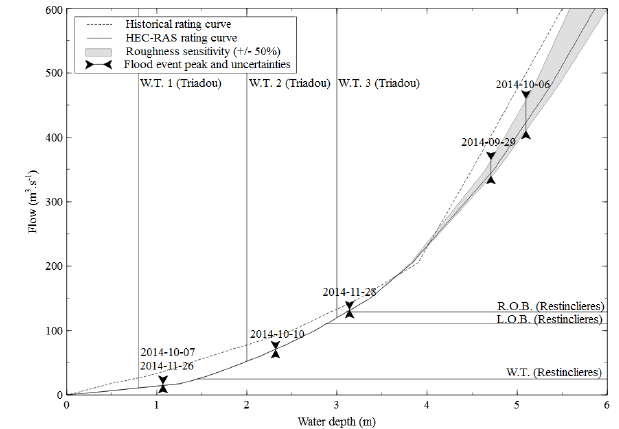
Figure 4. Calcium versus Magnesium concentration for each sam- ple. Grey square defines the water poles, and dotted circle the mo- ment of the sampling in the flood (main flood peaks are indicate by the date of the